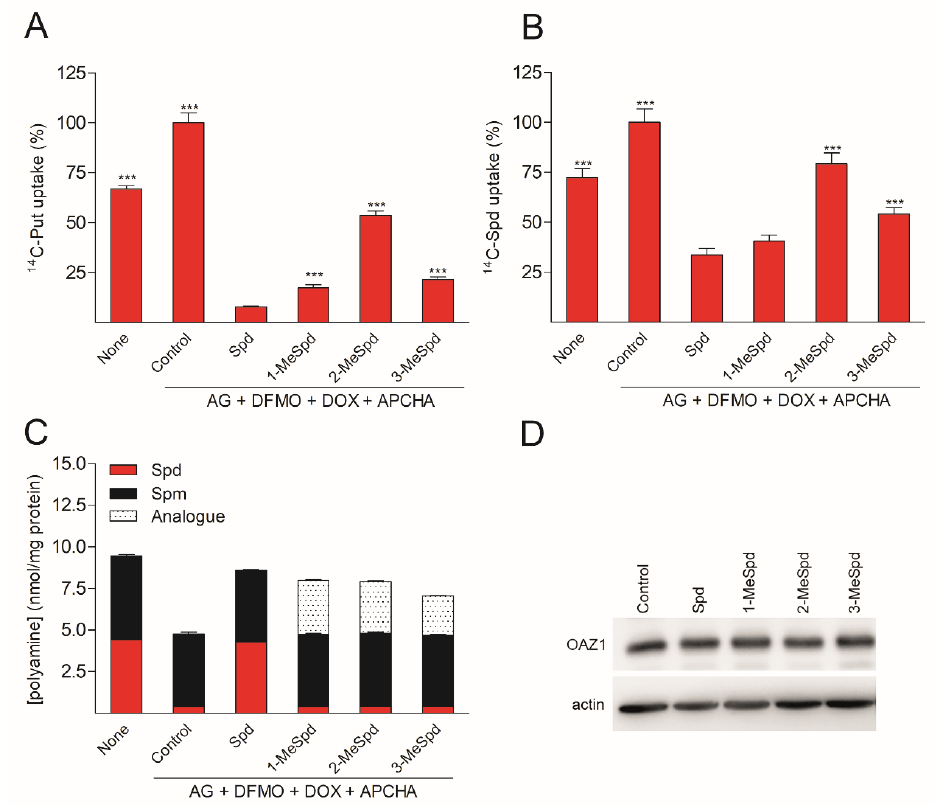
Figure 4. 2-MeSpd is the weakest downregulator of Put and Spm uptake in DU145 cells. ( A ) [ 14 C]-Put and ( B ) [ 14 C]-Spd uptake in OAZ1-overexpressing DU145 cells. The cells were first treated with DFMO (5 mM) for 3 days, after which DOX (1 µ g/mL) was added for further 2 days to induce OAZ1 overexpression. Then, AG (1 mM), APCHA (50 µ M), and Spd/analogue (100 µ M) were added for 4 h. The plates were washed, and 20 min [ 14 C]-Put or [ 14 C]-Spd (10 µ M) uptake assays were performed. ***, p < 0.001 as compared to Spd-treated group. ( C ) Intracellular polyamine and analogue pools before [ 14 C]-Put/Spd uptake assays. ( D ) OAZ1 protein amount before [ 14 C]-Put/Spd uptake assays. Results are means ± SD, n = 3 biologically independent samples, representative of n = 3 independent